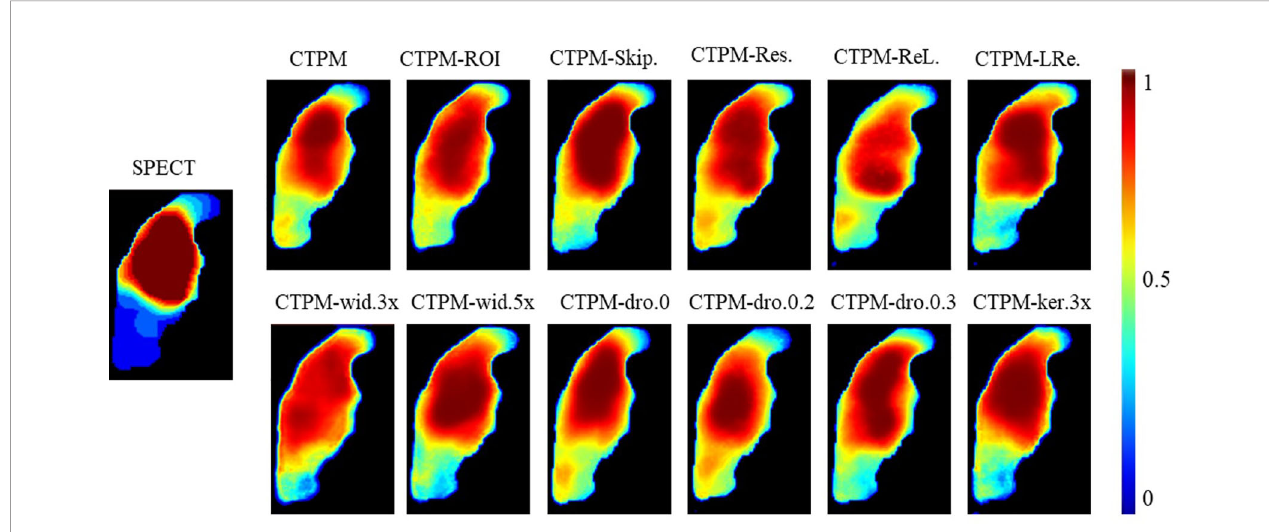
FIGURE 4 | Illustration of the effect of varying CNN components and con fi gurations of the representing case in coronal view. CTPM was generated using the proposed setting. The following CTPMs were generated in different CNN components and con fi gurations: ROI. — remove ROI attention module, Skip. — remove skip attention module; Res. — remove residual module; ReL. – use ReLU instead of PReLU; LRe. – use LReLU instead of PReLU; wid. — with CNN width of 3, 4, or 5 times; dro — with a dropout rate of 0, 0.2, or 0.3; ker 3× — use kernel size of 3 × 3 × 3 install of 5 × 5 ×